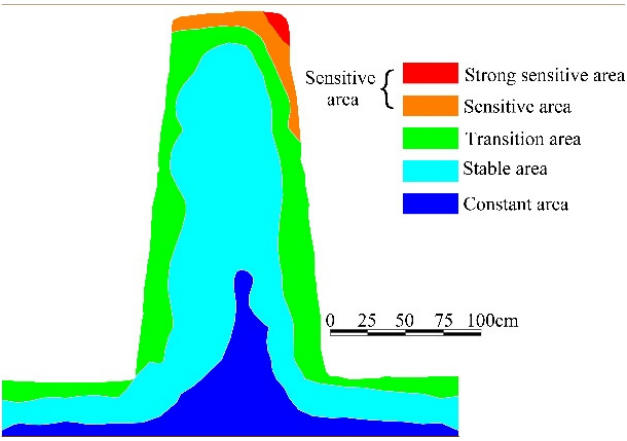
Figure 9. Temperature field of test wall in spring.